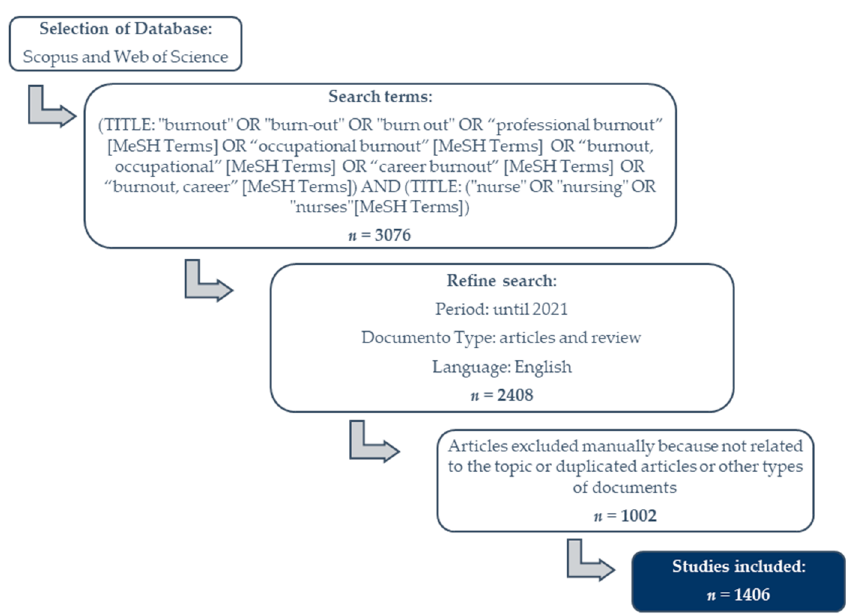
Figure 1. Bibliometric review sampling flowchart.